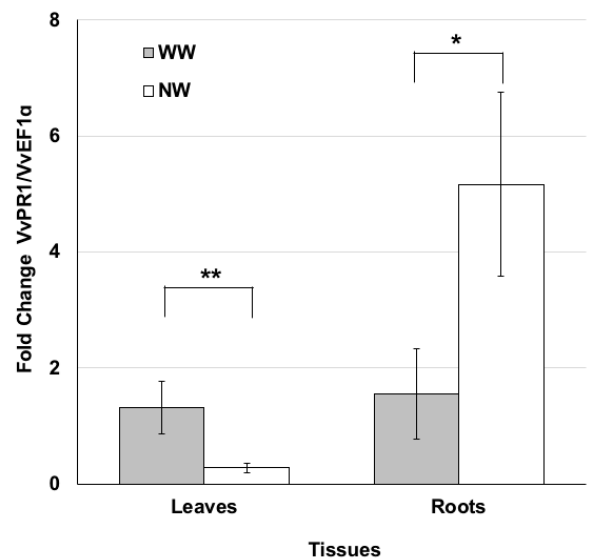
Figure 4. Nematode feeding modulates the expression of the pathogenesis-related protein PR1. Pattern of VvPR1 transcript accumulation analyzed by real time PCR in the leaf and root tissues of grape plants grown under nematode (NW) or control (WW) conditions for 3 months. Values represent the mean fold change variations ± SD of three and four independent biological replicates for WW and NW, respectively. Significant differences were assessed by Student’s t-test (df = 5) (* p < 0.05, ** p < 0.01). Table 1. Nematode population growth. Inoculum density (Inoculation N ◦ ) expressed as the number of dagger-nematodes introduced in each pot at the start of the experiment. The without wounding (WW) control plants did not receive the inoculum (-). An inoculum of 80 or 50 nematodes was dispensed to the nematode wounded (NW) grapevines. After 3 months, at the end of the experiment, the numbers of nematodes (Final N ◦ ) were analyzed. Three control (WW1-WW3) and six inoculated (NW1-NW6) plants were